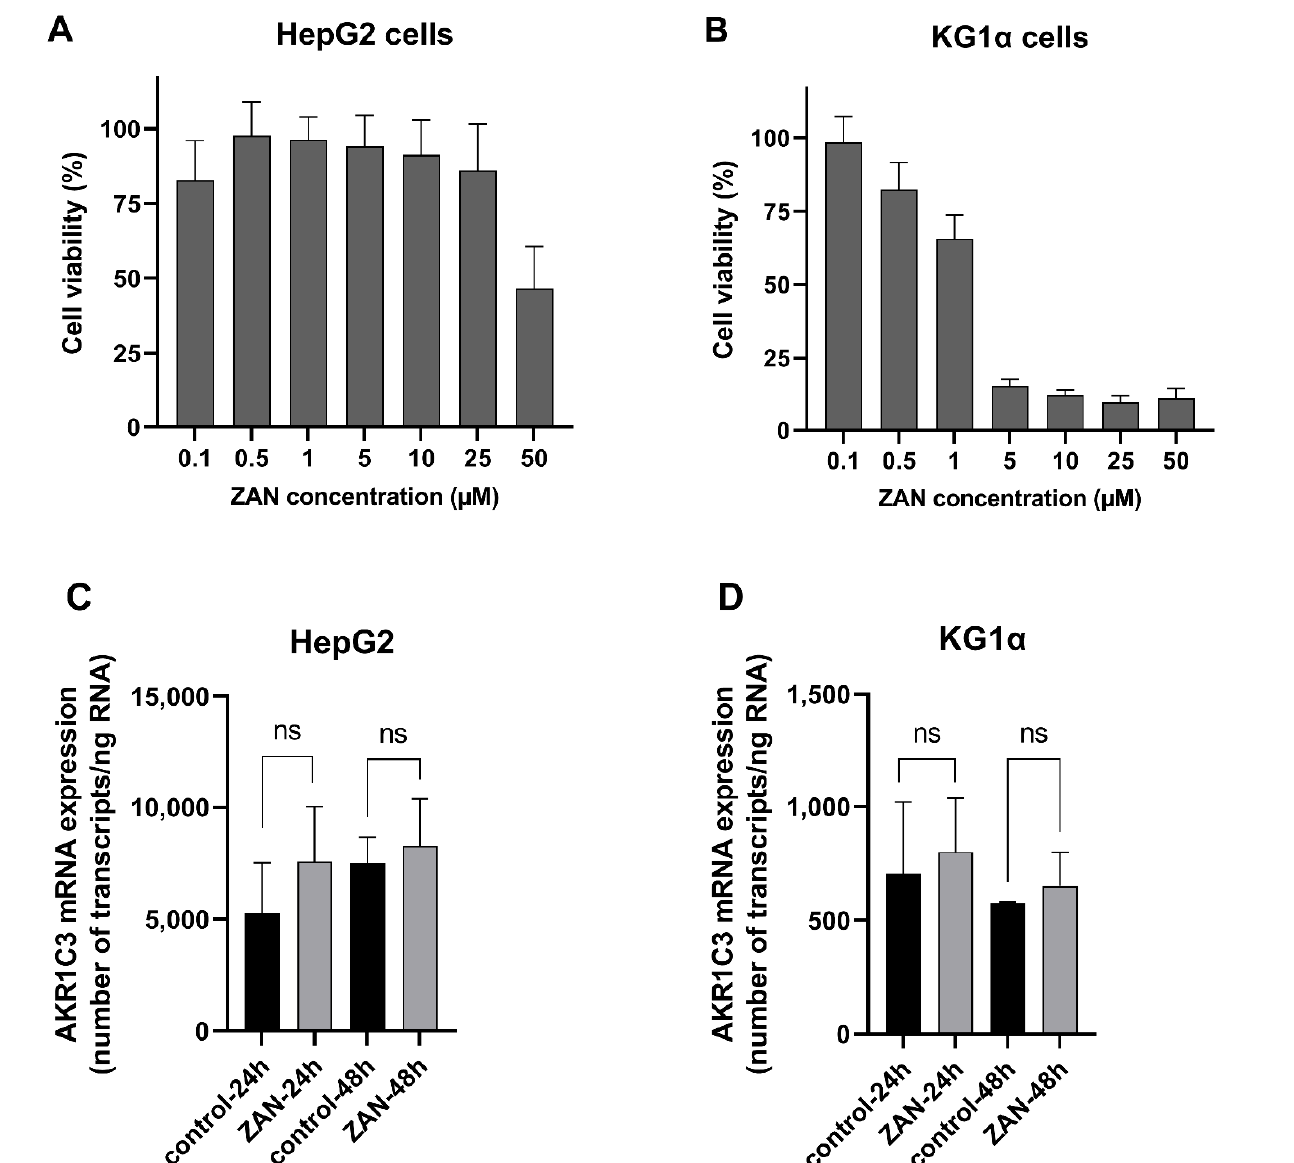
Figure 6. Effect of zanubrutinib (ZAN) on AKR1C3 mRNA expression in HepG2 and KG1 α cell lines. To find a non-toxic ZAN concentration, HepG2 ( A ) and KG1 α ( B ) cells were treated with ZAN (0.1–50 µ M) or dimethyl sulfoxide (DMSO) (a vehicle) for 48 h, and the cell viability was evaluated by the XTT test. Furthermore, determination of AKR1C3 mRNA following ZAN (0.5 µ